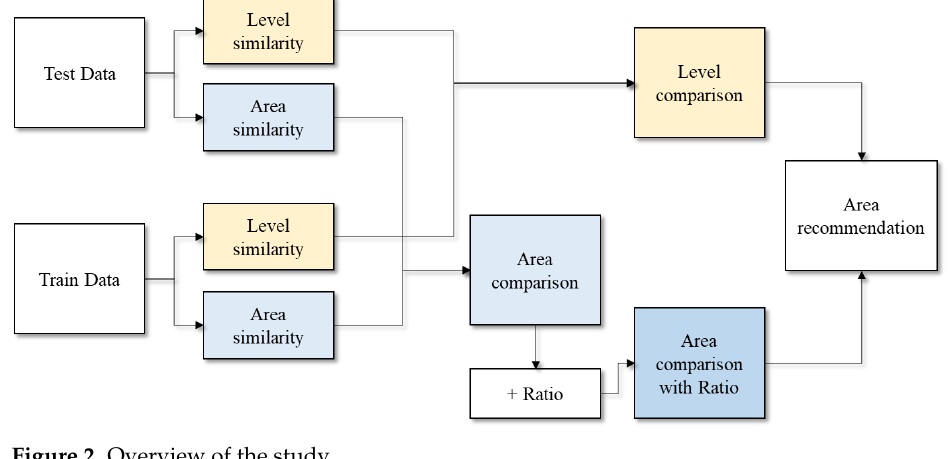
Figure 2. Overview of the